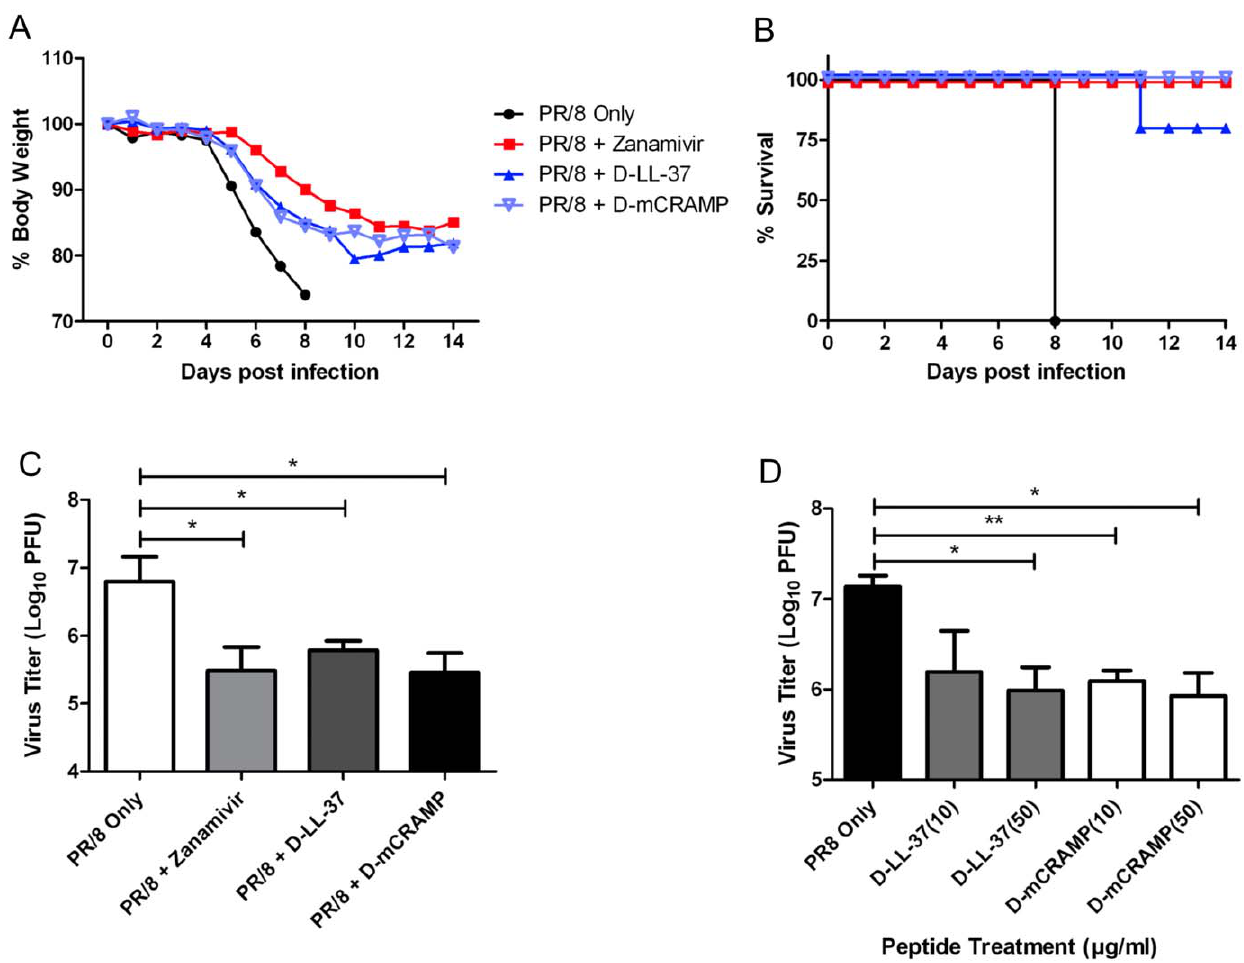
Figure 5. D-Isomer cathelicidins inhibit influenza virus. (A,B) Groups of 5 mice were infected with 10 MLD 50 of A/PR/8/34 influenza virus via intranasal administration on day 0. Mice were nebulized with 200 m l of saline (control), zanamivir (500 m g/ml), D-LL-37 peptide (500 m g/ml) or D- mCRAMP peptide (500 m g/ml) once daily from day -1 to day 7. Mouse weight and survival was monitored daily up to 14 days post infection. Data represent mean values 6 SEM from n=1 experiment. Statistical analysis was performed using Kaplan Meier with a Mantel-Cox (log rank) test. Survival curves obtained with Zanamivir, D-LL-37 and D-mCRAMP treatments were significantly different (P # 0.001) compared to saline control treatment. (C) Groups of 5 mice were infected with 10MLD 50 of A/PR/8/34 virus via intranasal administration on day 0. Mice were nebulized with 200 m l